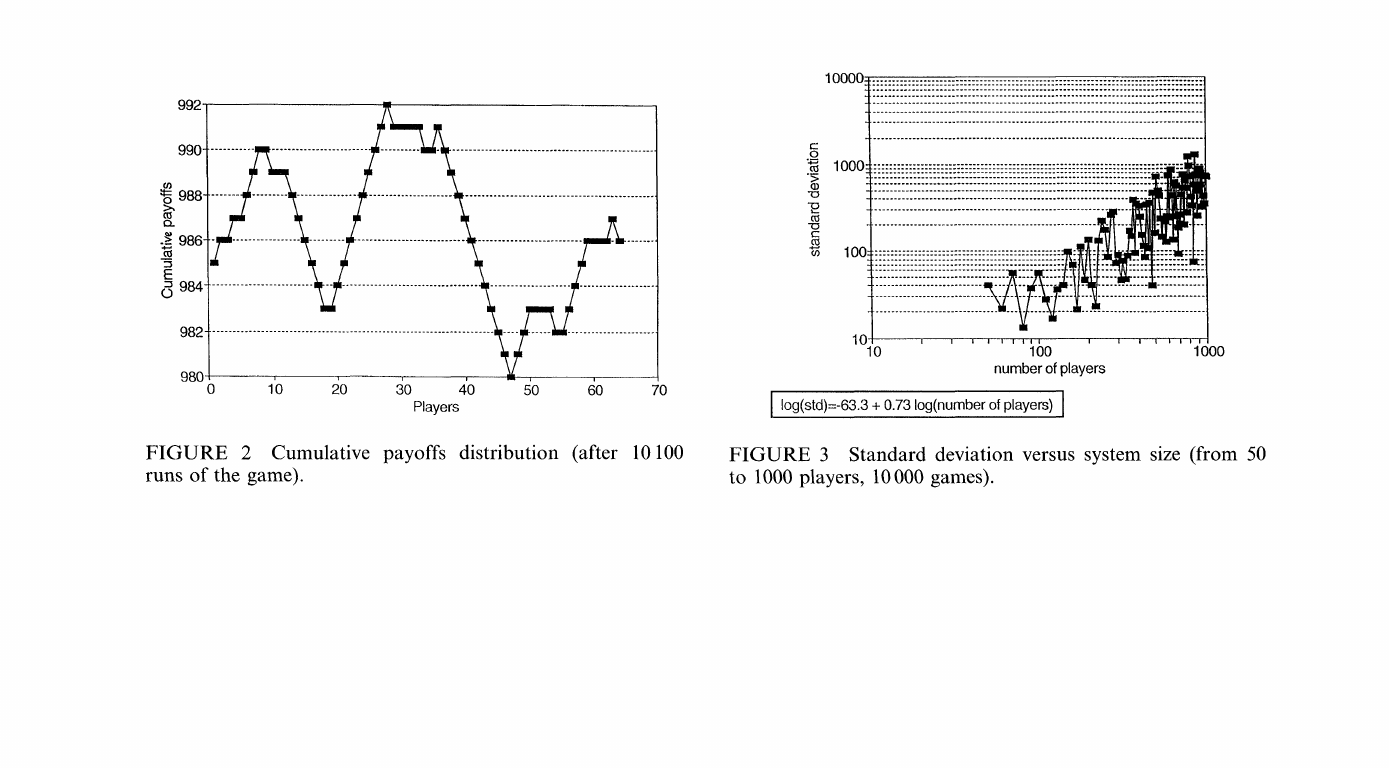
FIGURE 3 Standard deviation versus system size (from 50 to 1000 players, 10 000